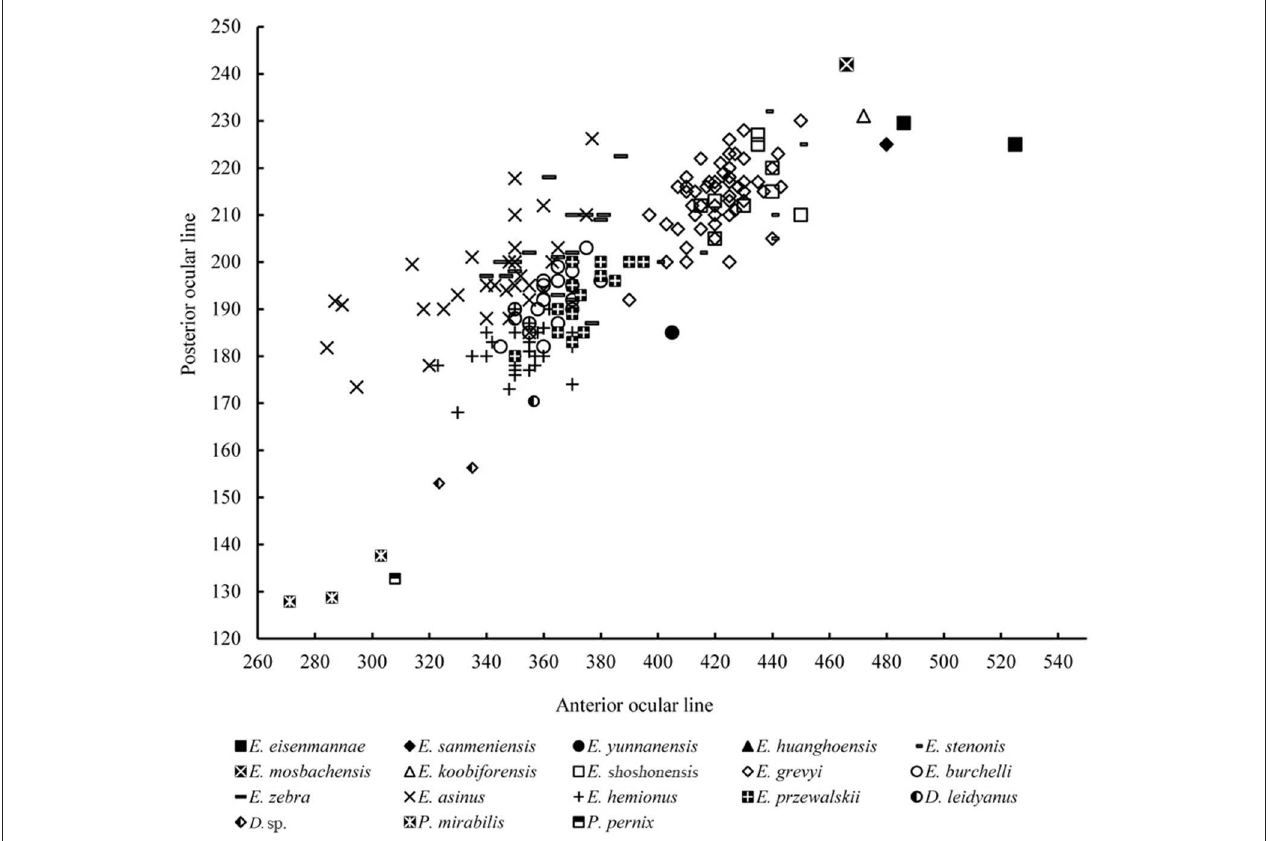
FIGURE 11 | Comparison of anterior and posterior ocular lengths in several extinct and extant species of